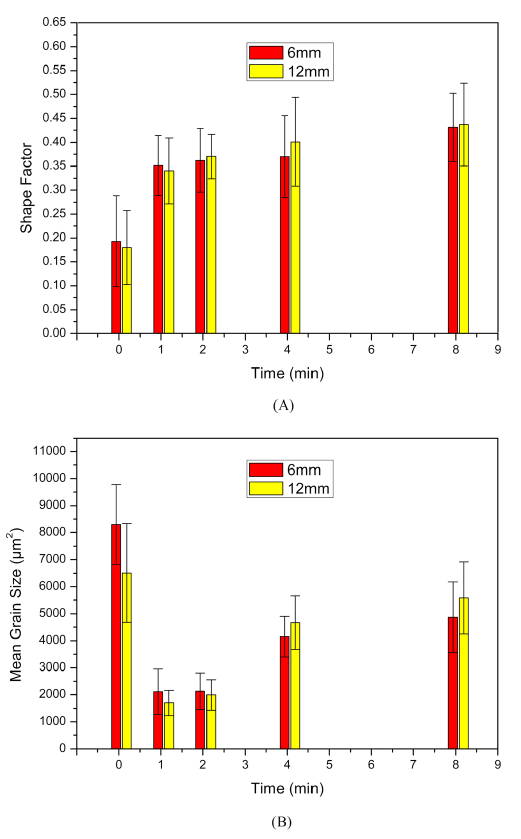
Figure 8. Elongation to fracture (A) and UTS (B) obtained from the tensile test at the different processing times and from the control sample